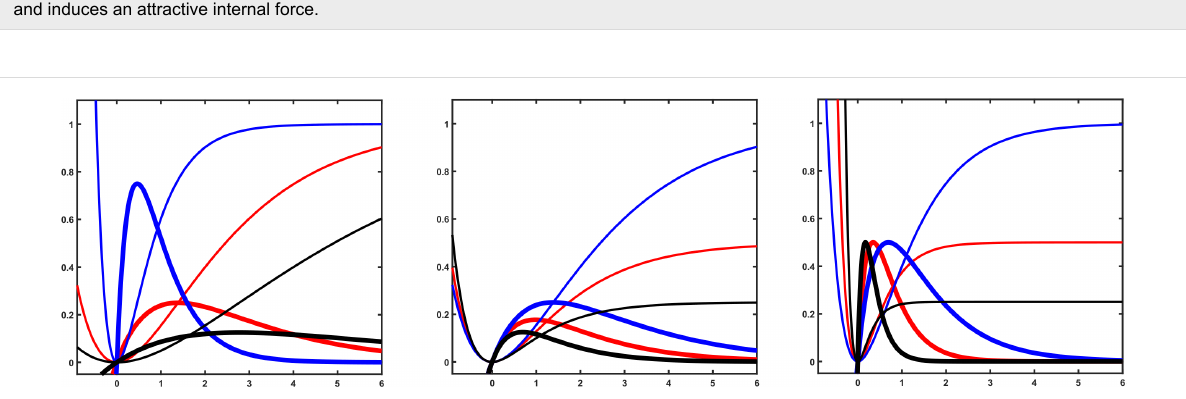
Figure 3: Potential functions (thin lines) and the first derivatives (thick lines). Left: For constant Δ V the maximum force decreases with decreasing curvature at the minimum. High curvature (blue), middle curvature (red), low curvature (black). Middle: For constant curvature the maximum force decreases with decreasing Δ V . Large Δ V (blue), middle Δ V (red), small Δ V (black). Right: Combination of large Δ V and small curvature may yield the same maximum force as small Δ V and large